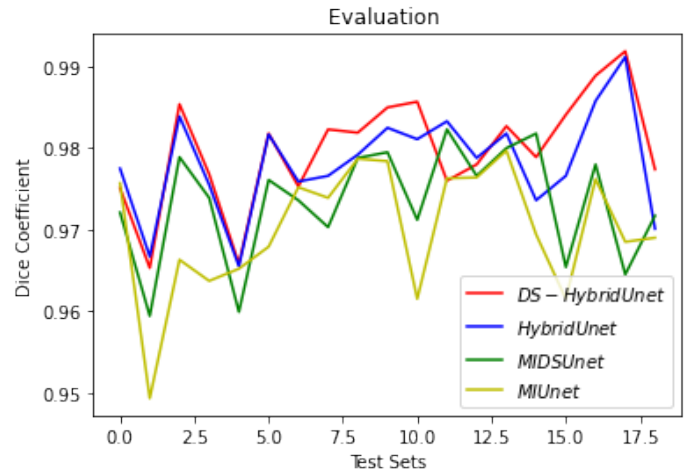
Figure 26. Comparison of Evaluation Dice